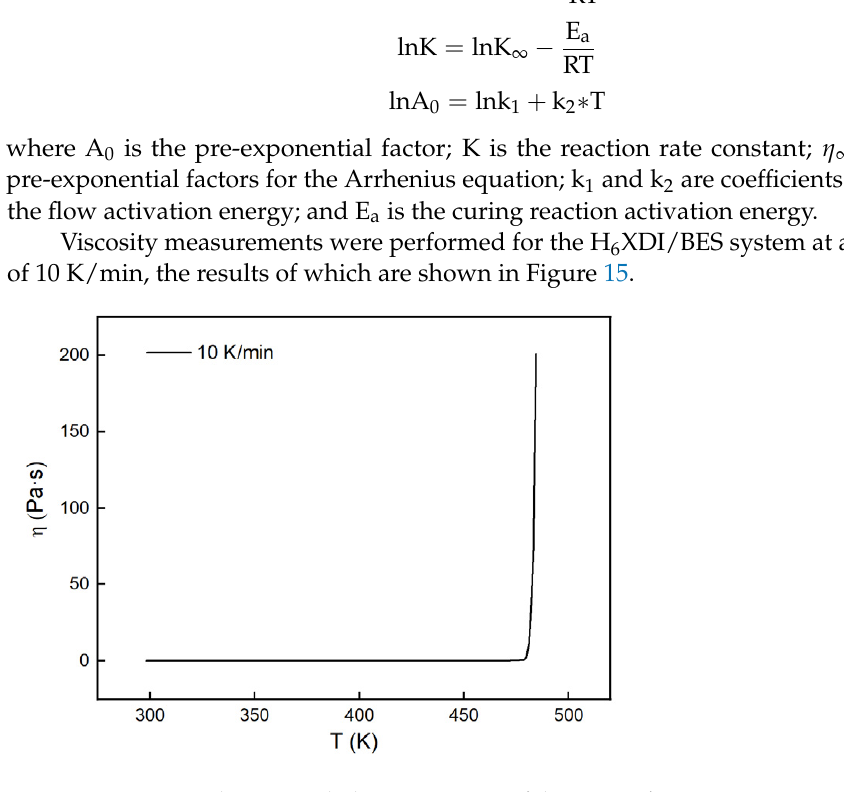
Figure 15. Viscosity changes with the temperature of the H 6 XDI/BES system. Three temperatures of 423 K, 433 K, and 443 K at which the viscosity changed slightly were chosen to measure the viscosity of the H 6 XDI/BES system, the results of which are shown in Figure 16. Figure 16. The viscosity of the H 6 XDI/BES system with time at constant temperatures.